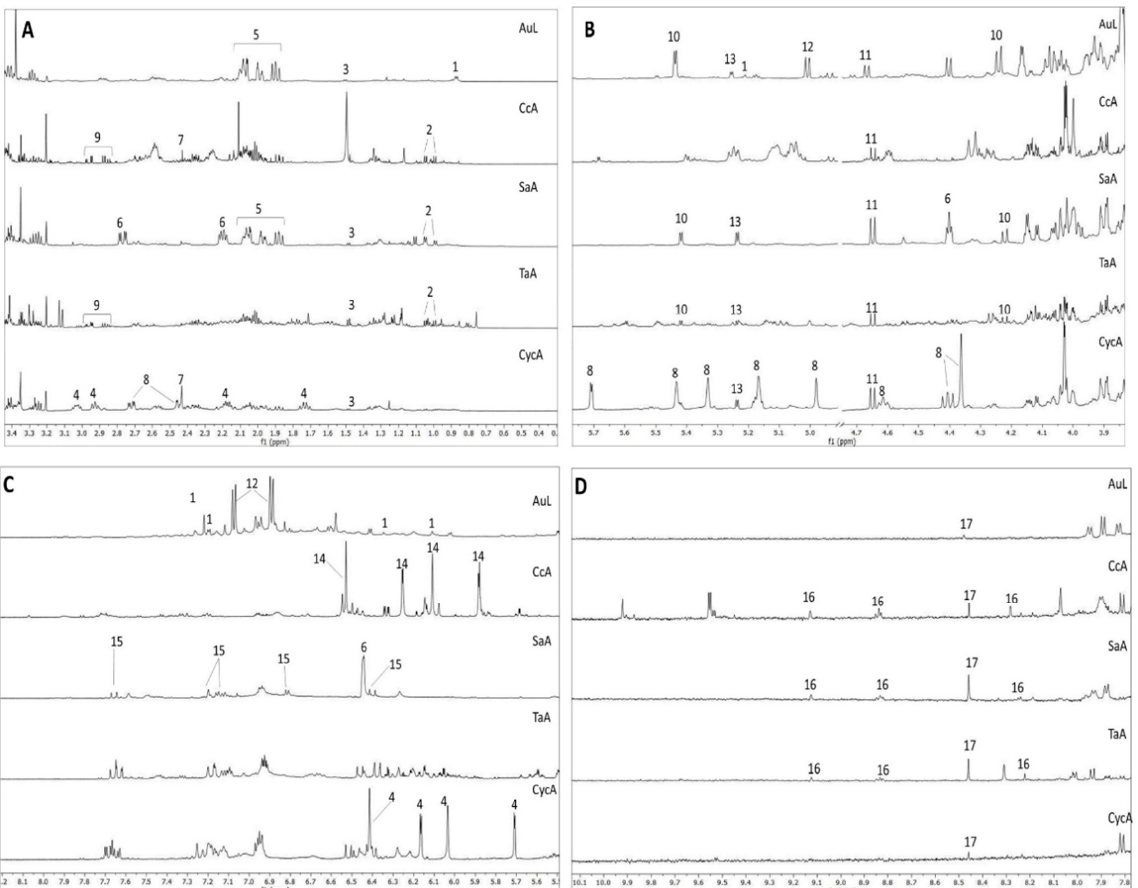
Figure 4. 1 H NMR extended spectral regions of AuL; CcA; SaA; TaA; CycA (from top to bottom). ( A ) region from δ 0.4 to 3.4; ( B ) from δ 3.4 to 5.4; ( C ) from δ 5.4 to 8.1; ( D ) from δ 7.8 to 10.00. Numbers indicate diagnostic signals of the most abundant metabolites: O -rhamnosyl flavonoid (1), valine (2), alanine (3), cynaropicrin (4), quinic acid (5), shikimic acid (6), succinic acid (7), malic acid (8), aspartic acid (9), sucrose (10), β -glucose (11), arbutin (12), α -glucose (13), sesquiterpene lactone-derivative (14), caffeic acid (15), trigonelline (16), formic acid (17). Spectra were measured in D 2 O-buffer (pH 6.0) using TMSP as standard, residual water signal has been removed.